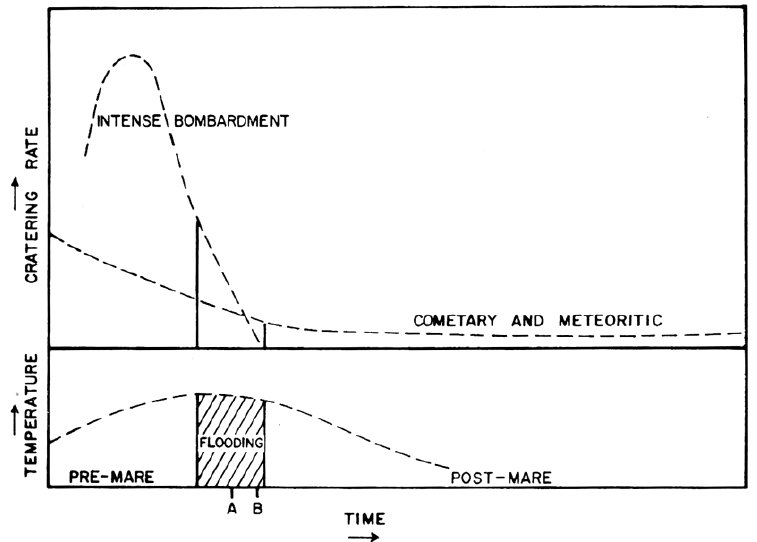
Figure 1. A 1966 visualization of lunar bombardment history, from a 1966 paper regarding “early intense bombardment.” The curve is based on a 1965 estimate of lunar maria having ~3.6 Ga age, and pre-mare uplands having (cid:38) 32 times the crater density as the maria. This required an average cratering rate, during pre-mare time, of (cid:38) 160 times the average post-mare cratering rate. The time-dependent structure of this early intense bombardment (“EIB”) remains unknown, even today. Original caption noted: “Two maria of nearly the same age, formed at A and B, could have appreciably di ff erent crater densities because of the decline in cratering.” (Hartmann 1966, his Figure 5